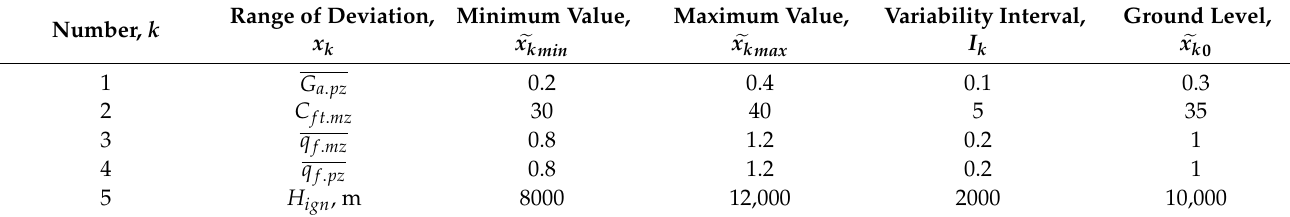
Table 4. Factors for fractional factorial experiment.